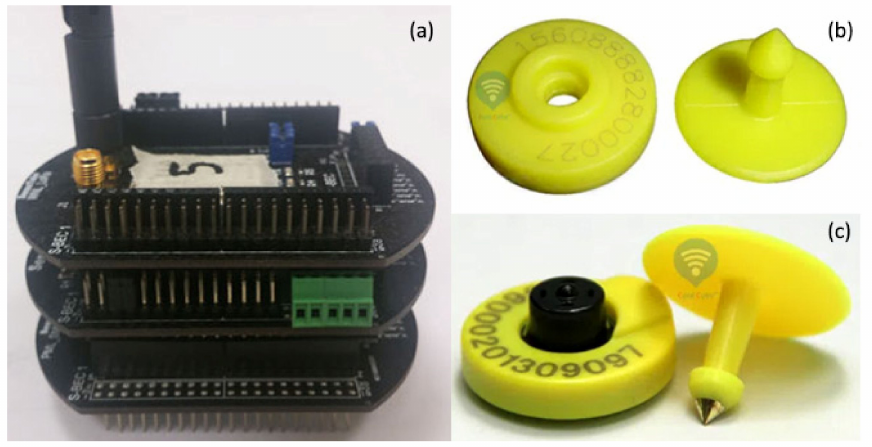
Figure 13. ( a ) SensoTube environmental sensor, ( b ) Mifare S-50 RFID ear tag, ( c ) Monza-5 RFID ear tag [113].